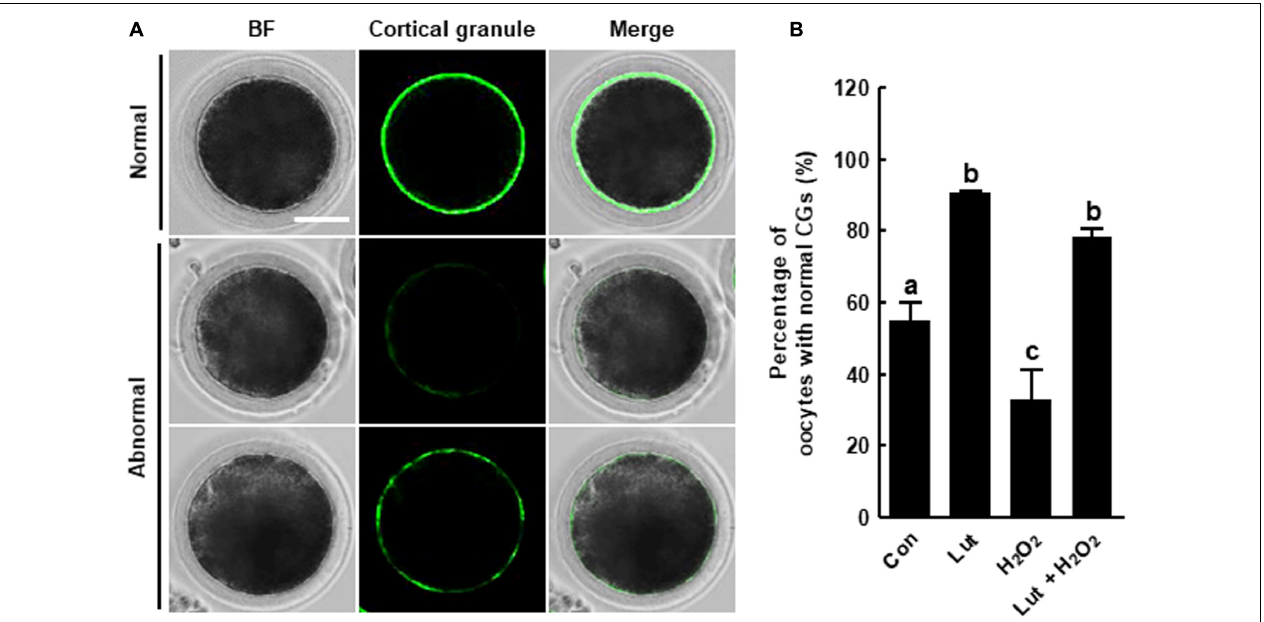
FIGURE 5 | Effects of Lut on H 2 O 2 -induced abnormal distribution of cortical granules (CGs). (A) Representative images of the normal and abnormal morphologies of CGs in porcine oocytes. Scale bar = 50 µ m. (B) Percentages of oocytes with a normal CG distribution in the indicated groups (Con, n = 44; Lut, n = 43; H 2 O 2 , n = 37; Lut + H 2 O 2 , n = 41). The data are from at least three independent experiments, and the different superscript letters represent the significant difference ( p <